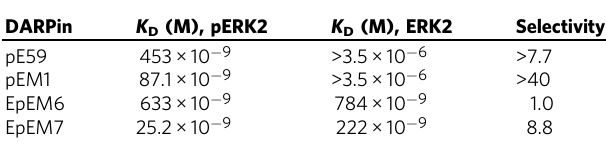
Table 1 Af fi nity and selectivity of selected DARPins for ERK2 and